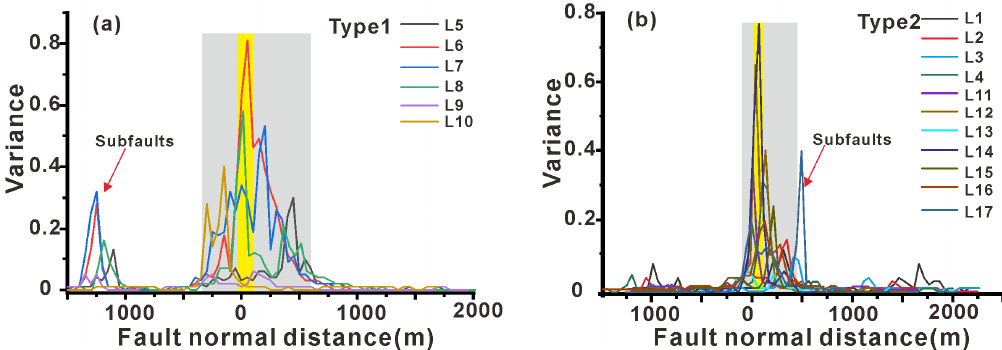
Figure 7. Profiles of the seismic variance values across the Shunbei 5 fault zone; ( a ) The type 1 damage zone; ( b ) The type 2 damage zone. Profiles location shown in Figure 4a.